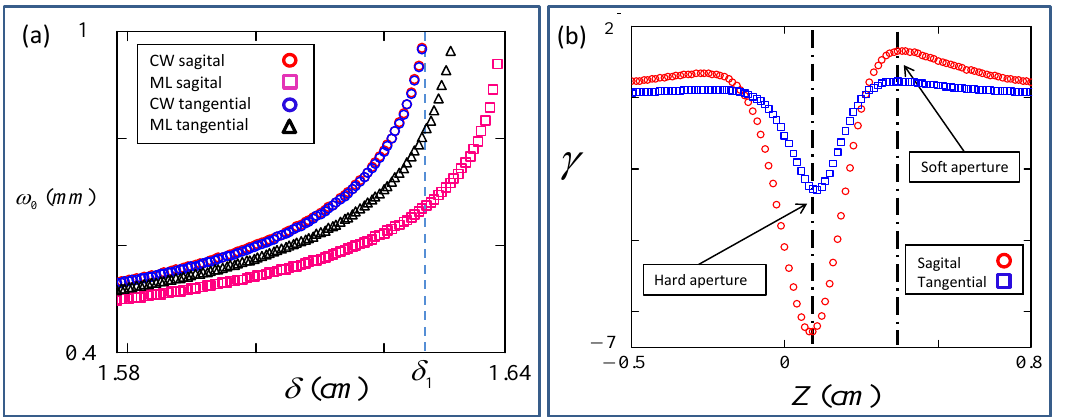
Figure 7. ( a ) ML and CW mode size for both sagittal and tangential planes on the end mirror, EM 1 (short arm), near the CW stability limit, δ ( b ) Kerr strength γ at EM 1 as a function of the crystal position, Z , near the stability limit, δ 1